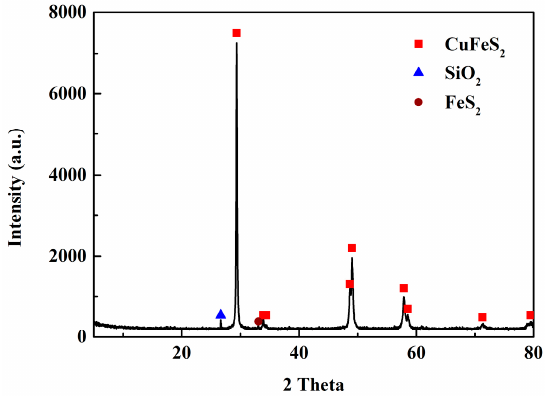
Figure 1. X-ray diffractogram pattern of the ore of chalcopyrite. Table 1. Chemical composition of the ore.